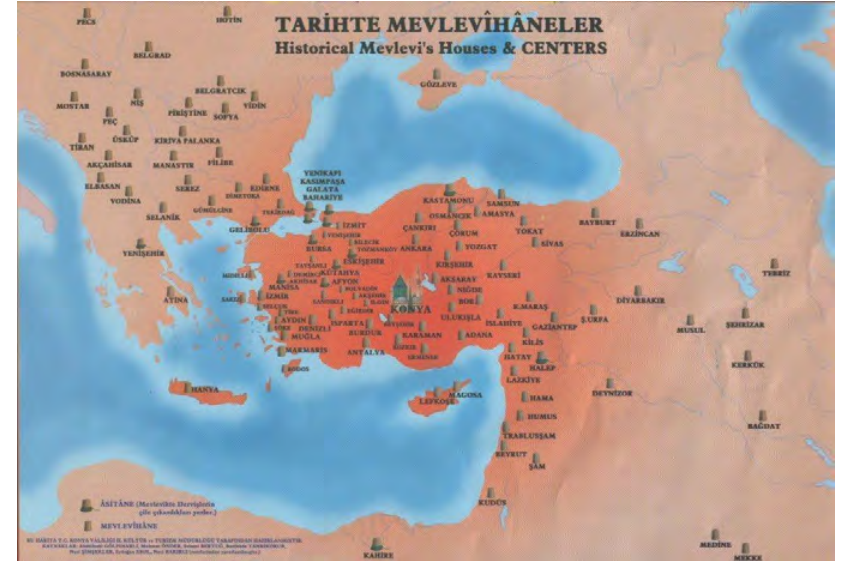
Figure 1. MevleviBuildings in Ottoman